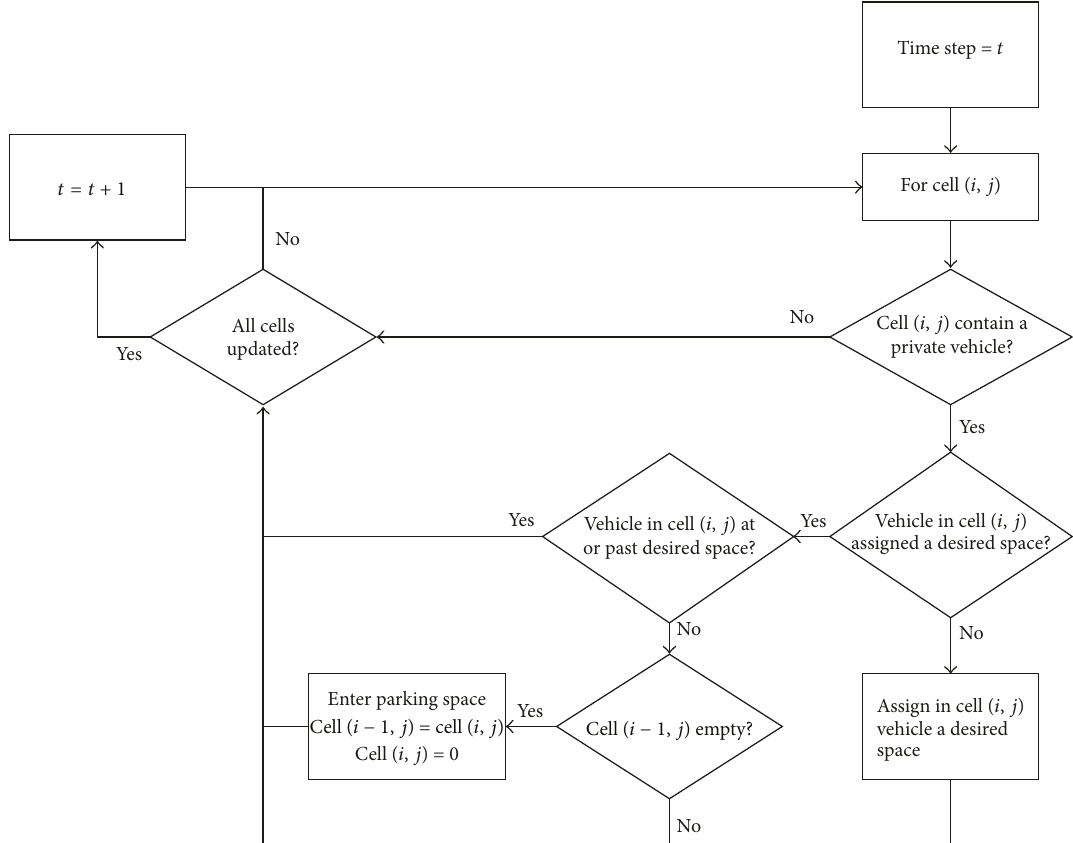
Figure 5: Algorithm for private vehicles entering a parking